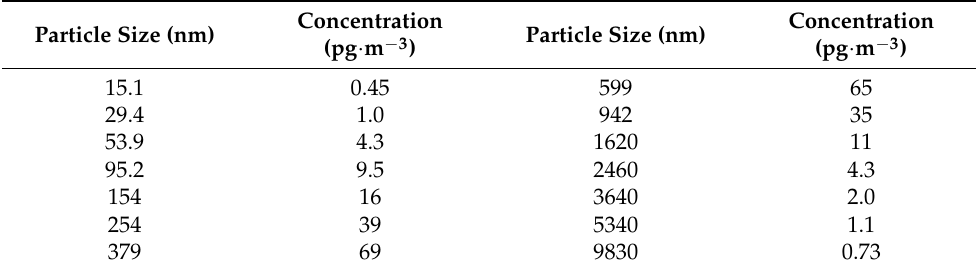
Table 2. Distribution of cadmium concentration on the aerodynamic diameter of particles (the values are not rounded but intentionally left as obtained, as only one data collection was performed).